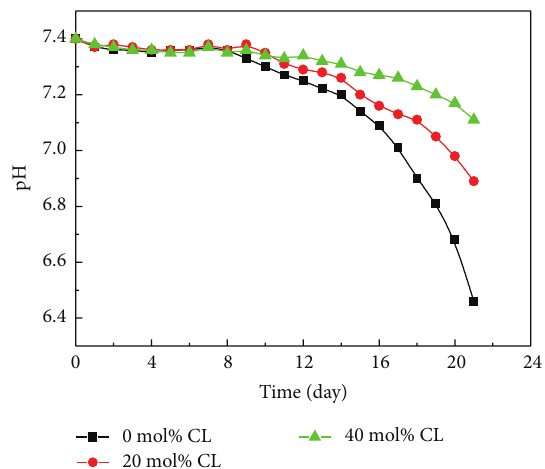
Figure 9: The changes in the pH of PBS solutions during the degradation process of the PLGC